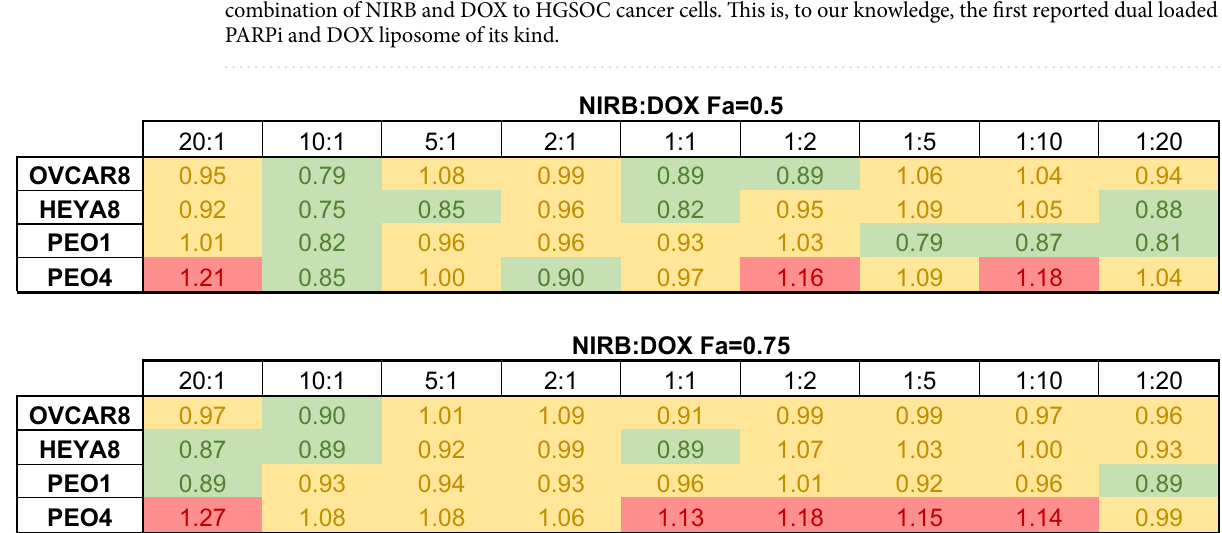
Table 1. Heat map showing mean CI values at (A) Fa = 0.5 and (B) Fa = 0.75 for treatments of NIRB:DOX at varying relative molar ratios in a panel of four HGSOC cell lines. CI values ≤ 0.9 indicates synergistic effects (green), 0.9 > CI < 1.1 indicates additive effects (yellow), and CI ≥ 1.1 indicates antagonistic effects (red). The 10:1 molar ratio is shown to have consistent mean synergistic/additive effects in all cell lines at both Fa = 0.5 and Fa = 0.75. CI values were calculated using CompuSyn